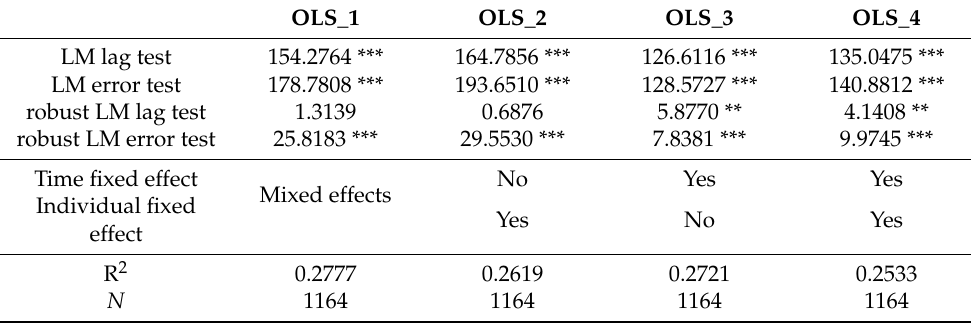
Table 5. Results of LM test, LR test, and Wald test for robustness check.